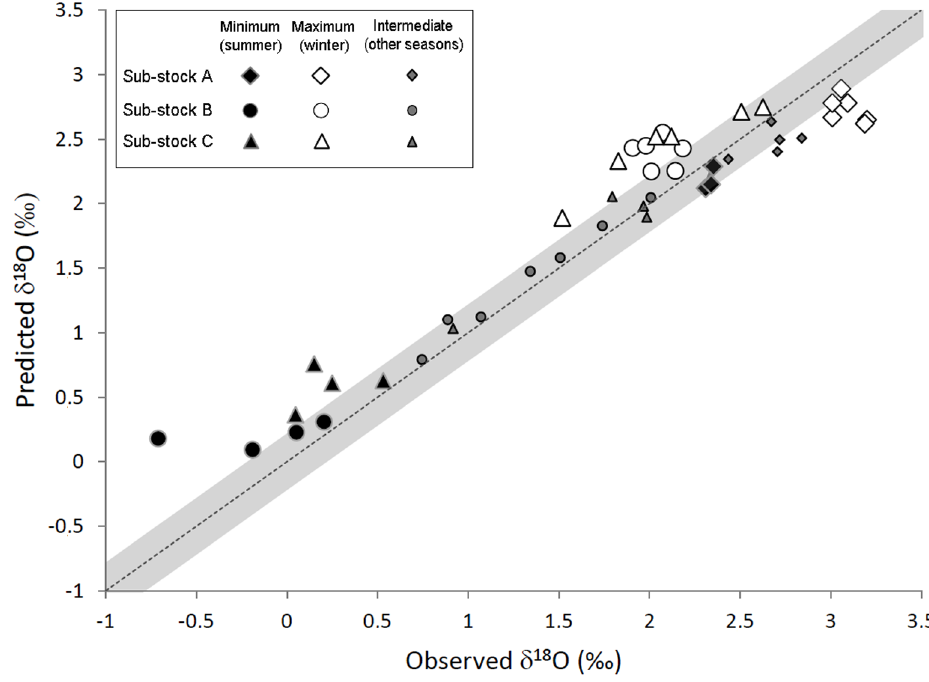
Figure 6. Sub-stock specific vital effects? Measured vs . predicted intra-annual otolith d 18 O values obtained for the 4 fish per sub-stock analysed with SIMS. In each case, intra-annual otolith d 18 O measurements made during DST recording time were matched with best corresponding monthly d 18 O values predicted from concomitant in situ tag temperature records using the equation from Kim et al. (2007). The grey area around the 1:1 line represents the analytical error using SIMS. NB: the number of measurements differs between sub-stocks due to inter-individual differences in tag recording times. For all individuals, minimum predicted monthly d 18 O values were consistently observed in the summer (in July, August or September) and maximum ones in the winter (in February or